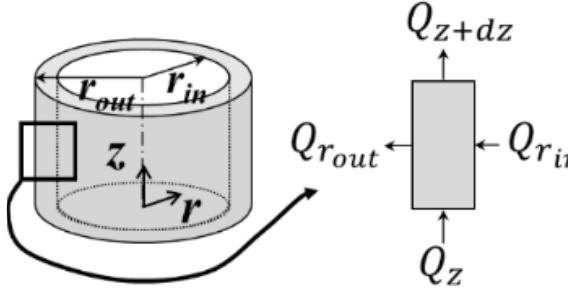
Figure 2. Energy balance at the infinitesimal wall section.